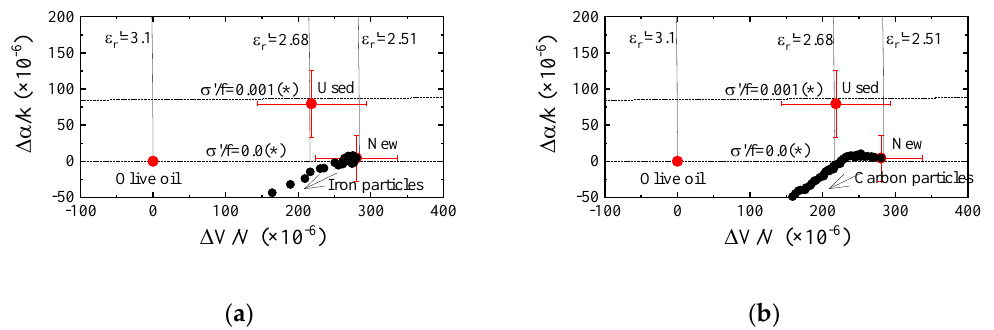
Figure 7. Evaluation of the electrical property changes of ( a ) iron and ( b ) carbon powders in new engine oil using the relative permittivity–conductivity chart. The arrow shows the direction of time. The results of olive oil and new and used engine oils are also plotted in the figure. (*: 1 × 10 − 8 (S/m)/Hz).